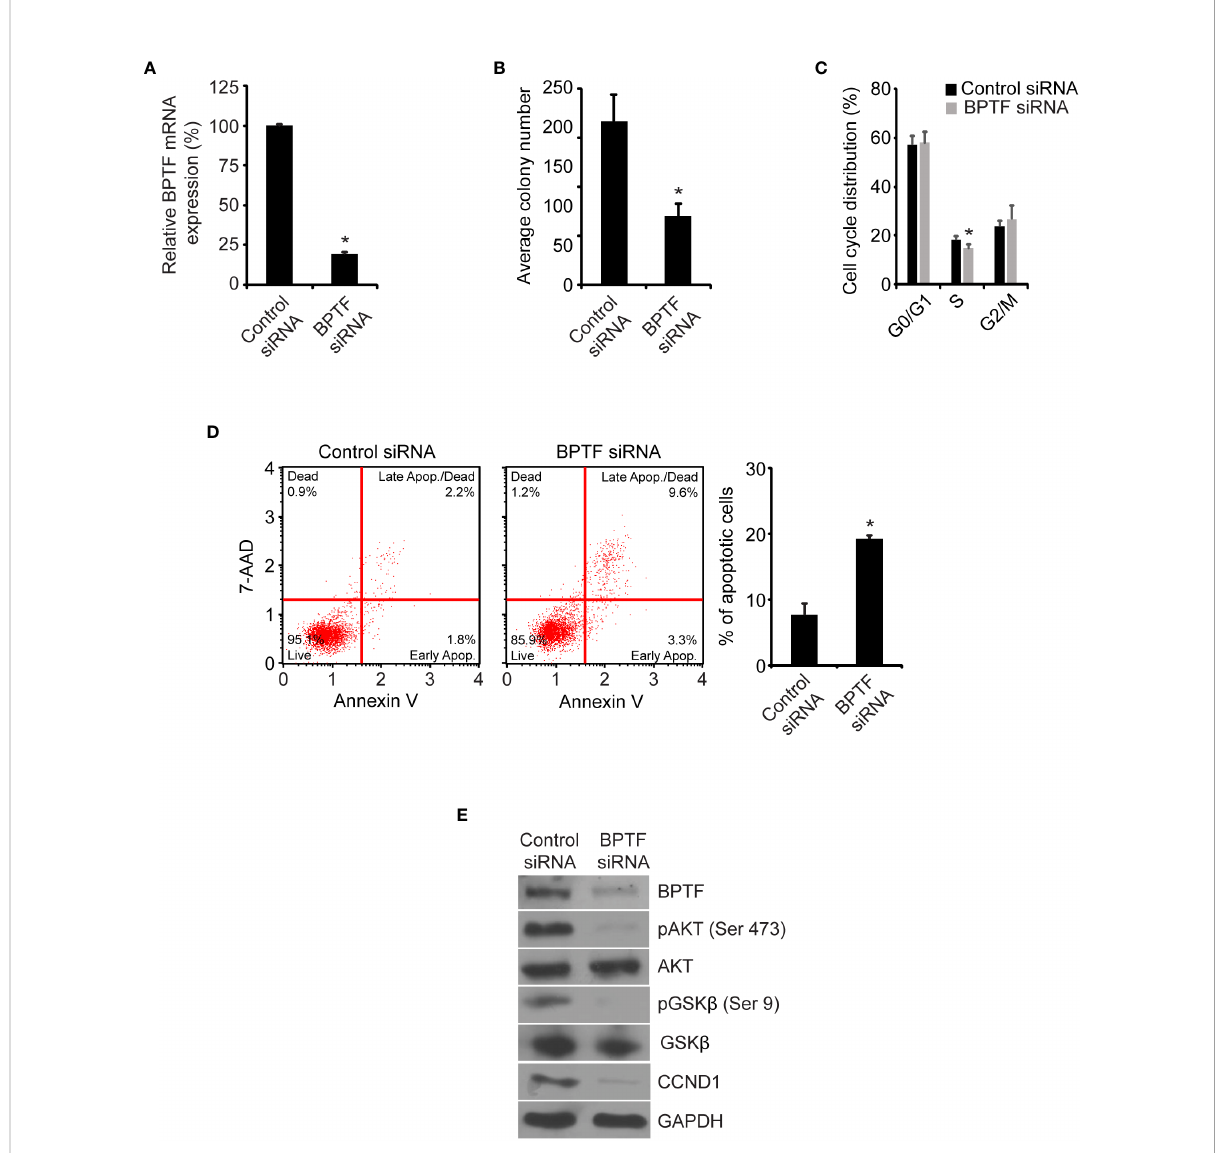
FIGURE 3 Effects of siRNA-mediated suppression of BPTF on MDA-MB-231 cells. (A) BPTF mRNA expression after siRNA knockdown. (B) Mean colony number after BPTF knockdown. (C) Cell cycle analysis following siRNA-mediated suppression of BPTF . (D) Analysis of apoptotic rate after BPTF silencing based on detection of 7-AAD and Annexin V. (E) Western analysis of expression of various proteins following siRNA-mediated BPTF knockdown. *p <